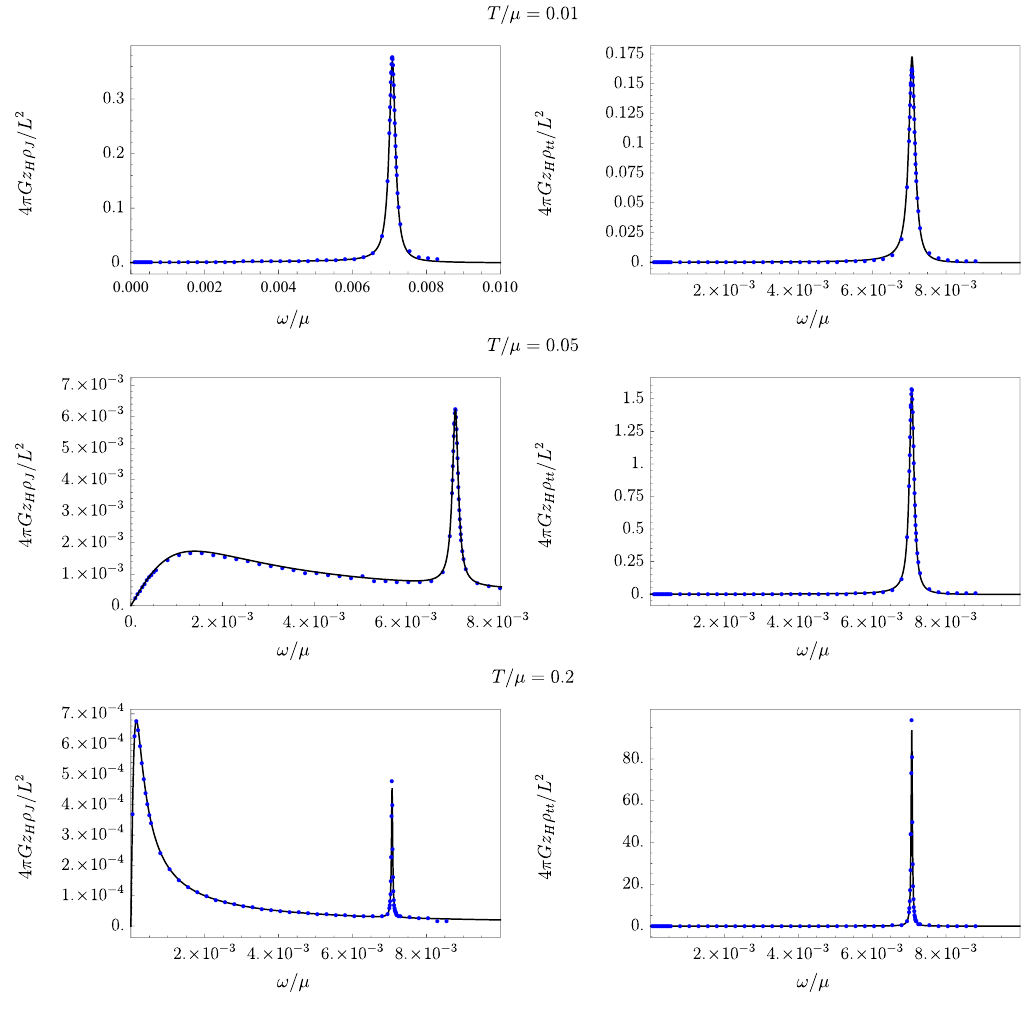
Figure 14. Our numerical results (blue dots) for the charge spectral function, (cid:26) J (left column) and energy spectral function, (cid:26) tt (right column), each made dimensionless by a factor of 4 (cid:25)Gz H =L 2 , as functions of !=(cid:22) for (cid:28) = 10 (cid:0) 3 , ~ (cid:11) = 1, k=(cid:22) = 0 : 01 and T=(cid:22) = 0 : 01 (top row), 0 : 05 (middle row), and 0 : 2 (bottom row). The solid black lines come from the sum-of-poles approximation to the Green’s functions in eq. (3.6). As T=(cid:22) increases, the behaviors of both (cid:26) J and (cid:26) tt are similar to the (cid:28) = 10 (cid:0) 4 case in (cid:12)gure 13: in (cid:26) J the sound peak shrinks while the charge di(cid:11)usion peak grows,